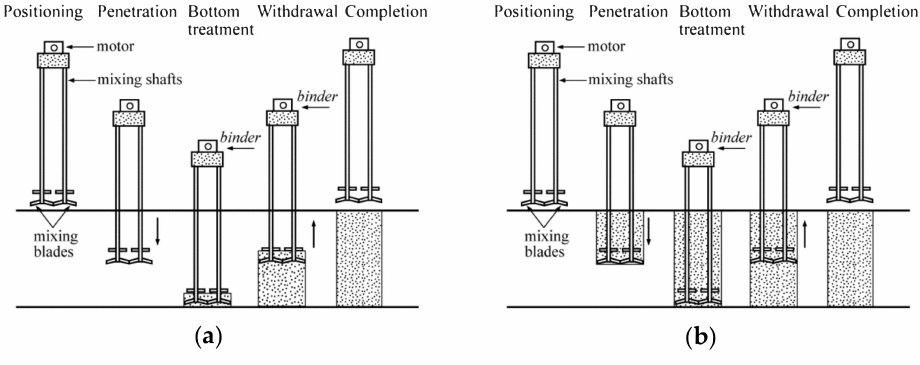
Figure 2. Production of the DM-stabilized soil column. ( a ) Penetration injection method; ( b ) with- drawal injection method.